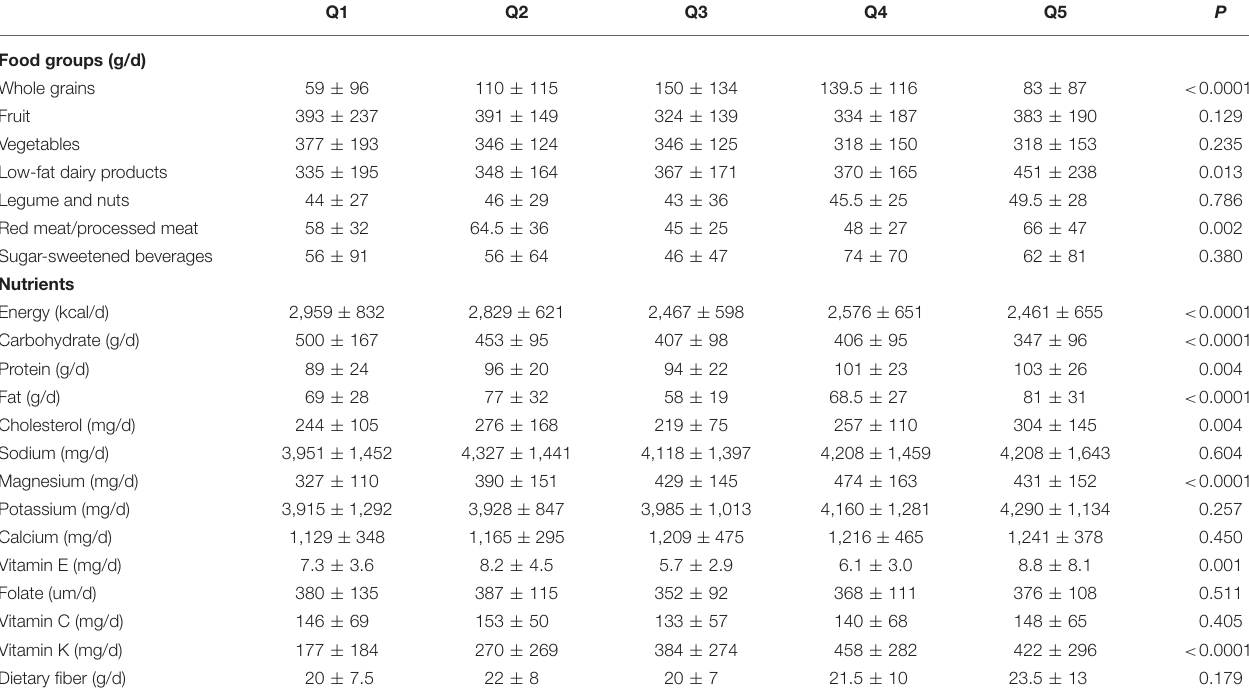
TABLE 4 | Mean dietary intakes of study participants among quintiles of LCD score. Q1 Q2 Q3